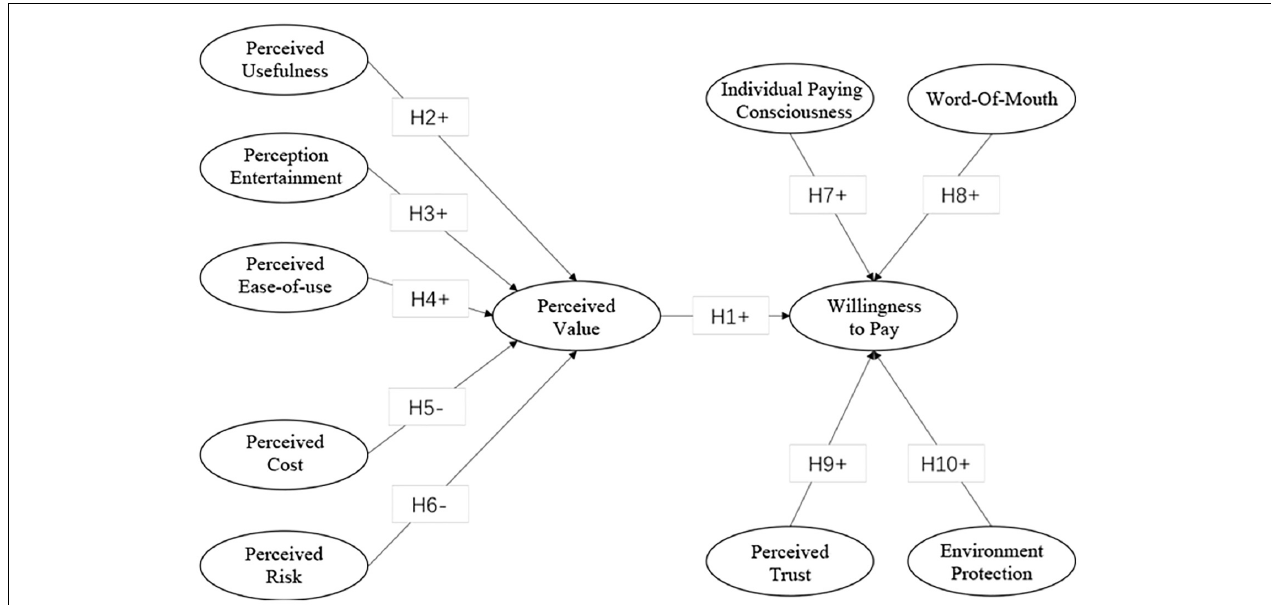
FIGURE 1 | Theoretical